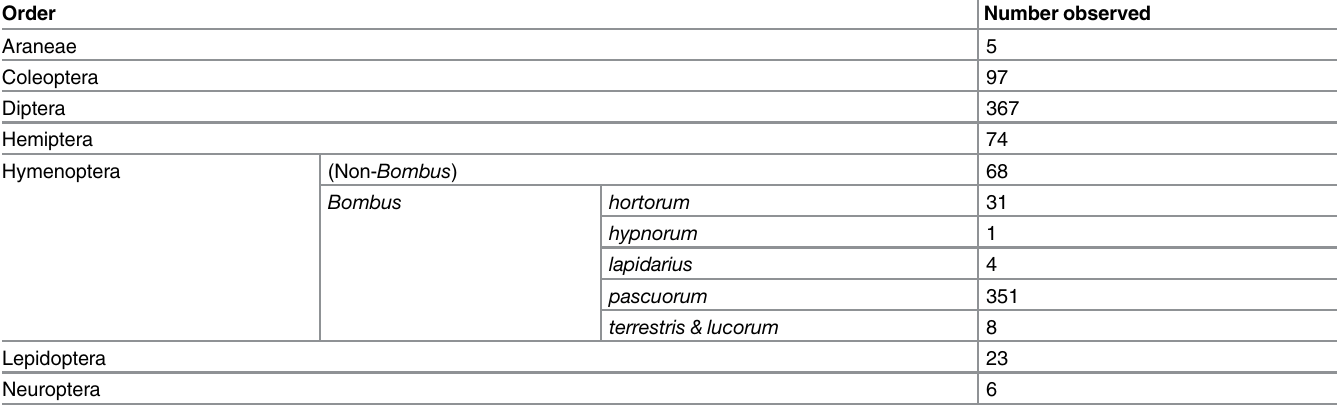
Table 1. Total observed orders and species visiting Trifolium pratense between 20th May 2013 and 22nd July 2013.